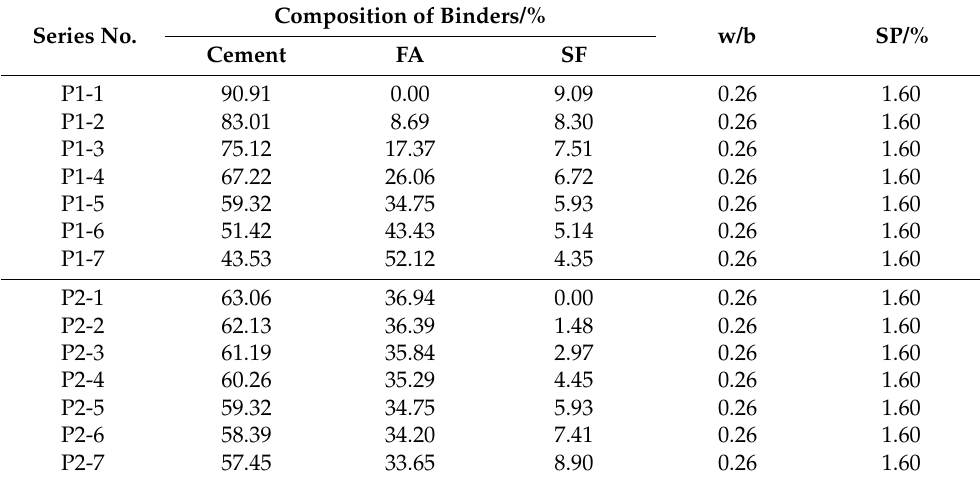
Table 2. Mix proportions of